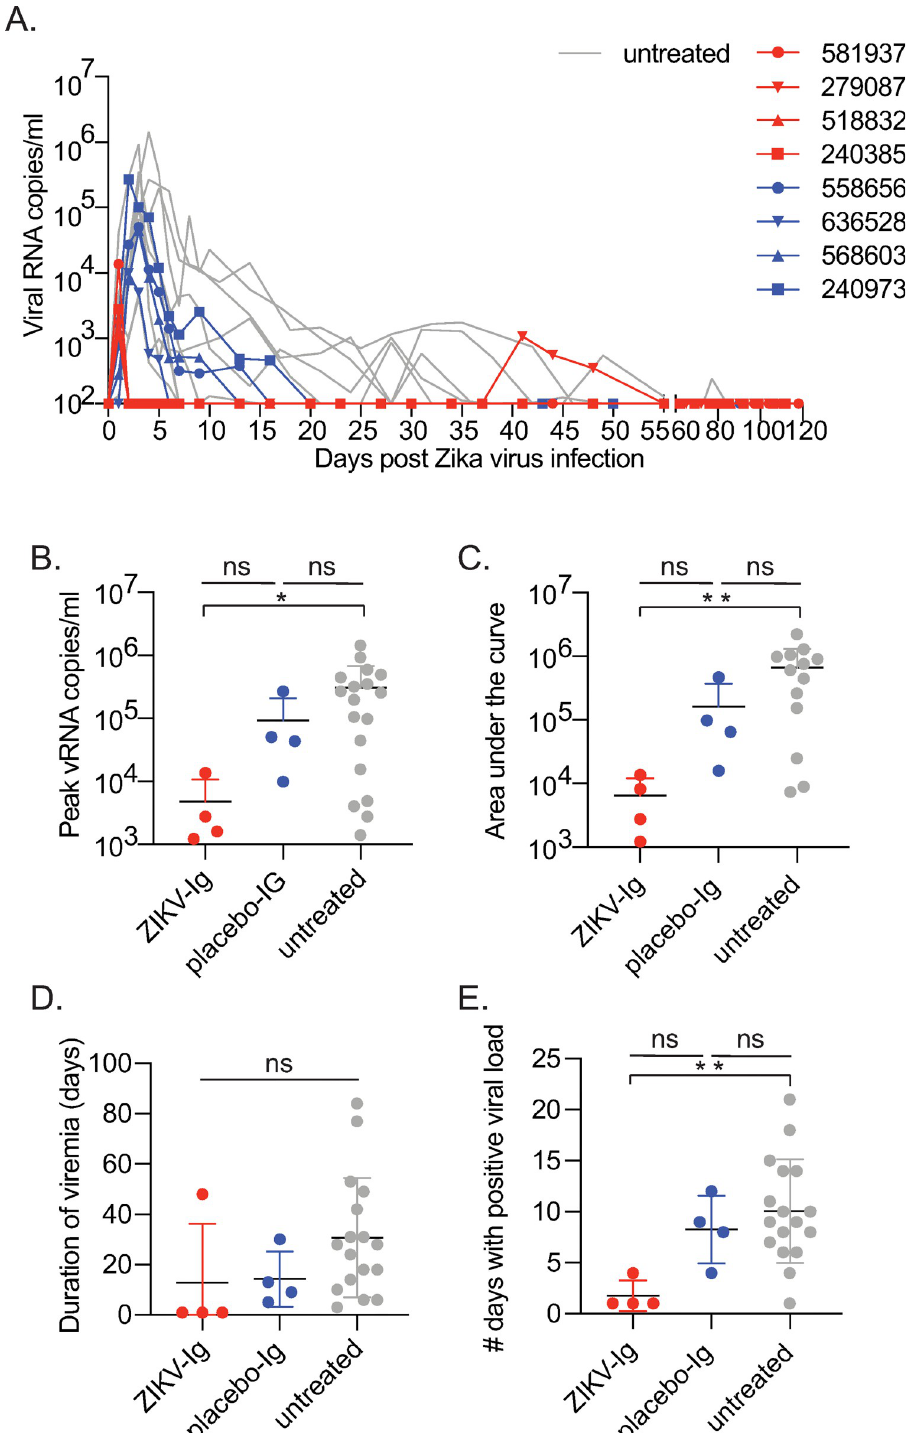
Fig 2. Dam viral load analysis between ZIKV-IG, placebo-IG, and untreated animals. ( A ) Longitudinal plasma viral load for animals across each group. Red = ZIKV-IG-treated, blue = placebo-IG-treated, gray = untreated. The x-axis is set to the limit of quanti of the assay (100 copies/ml). ( B ) Peak viral load was statistically different for each group shown with the mean and standard deviation (Kruskall-Wallis chi-squared = 7.1263, df = 2, p = 0.03). ZIKV-IG- treated dams had lower viremia levels than untreated controls (p = 0.02; � p < 0.05), but placebo-IG-treated animals did